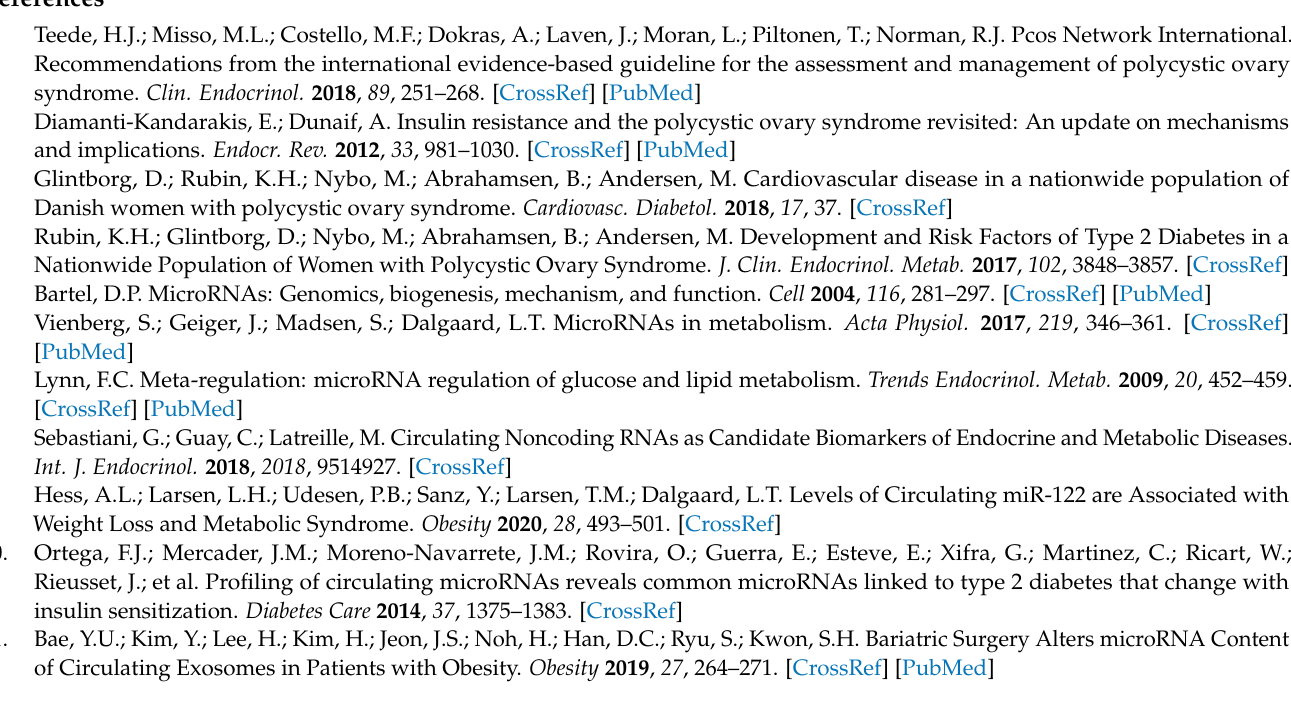
Table S2: Change in miRNA levels in women without PCOS from BL to FU. Figure S1: ROC curve of free T in which age and BMI at BL was included in the logistic regression model. Figure S2: Correlations between clinical and biochemical variables and the selected miRNAs, at either BL or FU, measured in women with